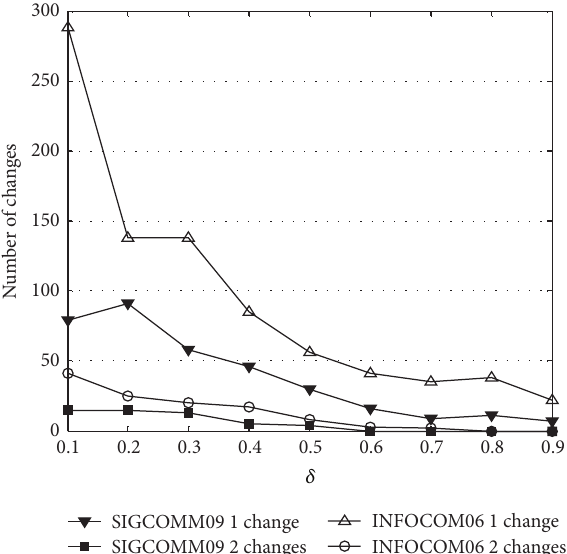
Figure 13: Number of changes in core matrix with different 𝛿 .